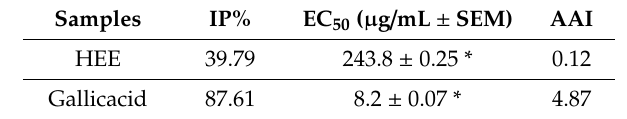
Table 1. Antioxidant activity of the hydroethanolic extract of C. argyrophyllus determined by a DPPH test.